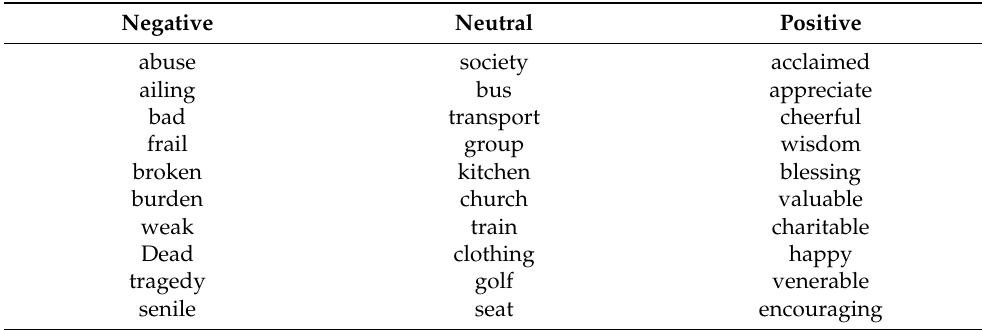
Table 1. Examples of Negative, Neutral and Positive Descriptors of Older Adults in the